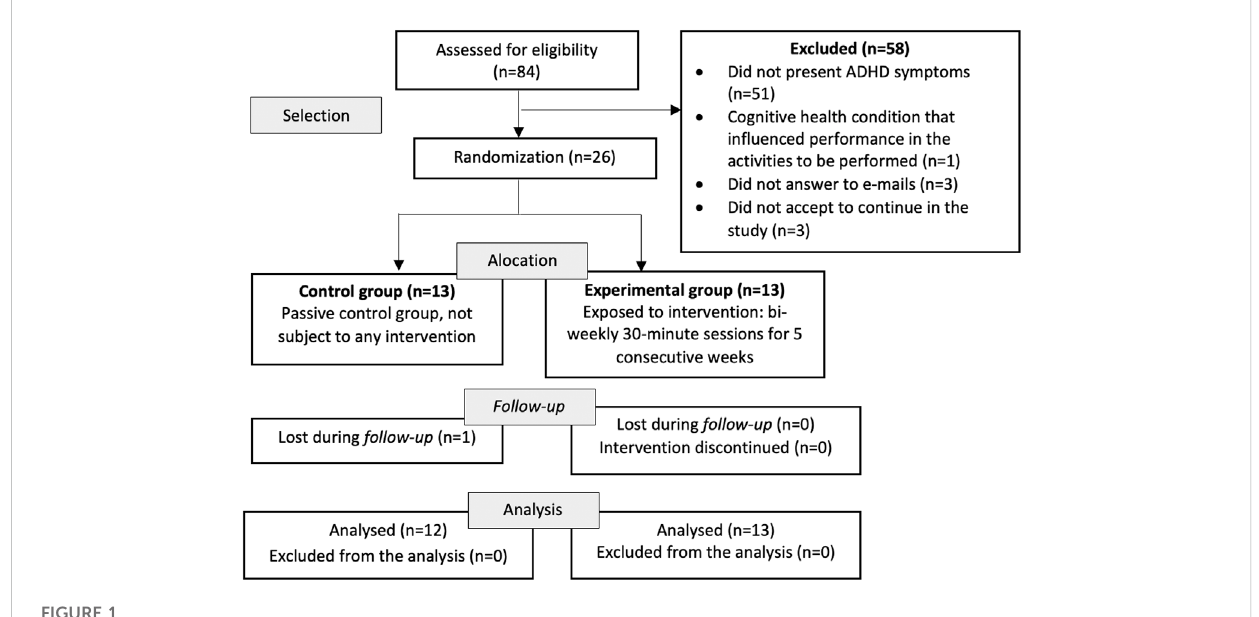
FIGURE 1 Flowchart of the allocation of